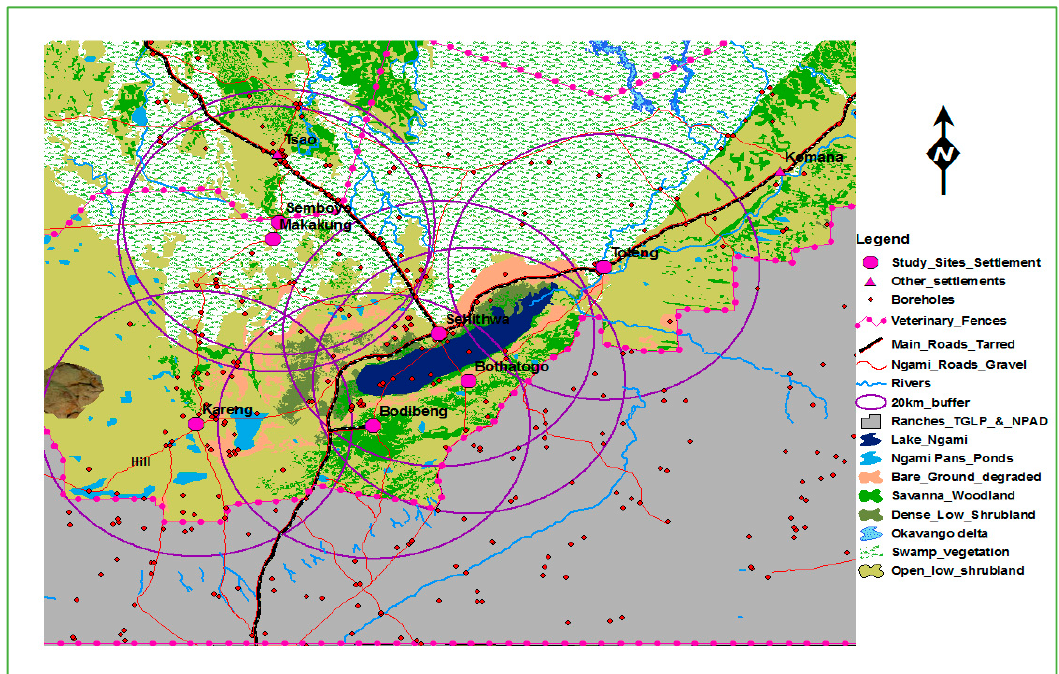
Figure 4. 20 km buffer zones around study villages and the encroachment of ranches in village grazing areas.